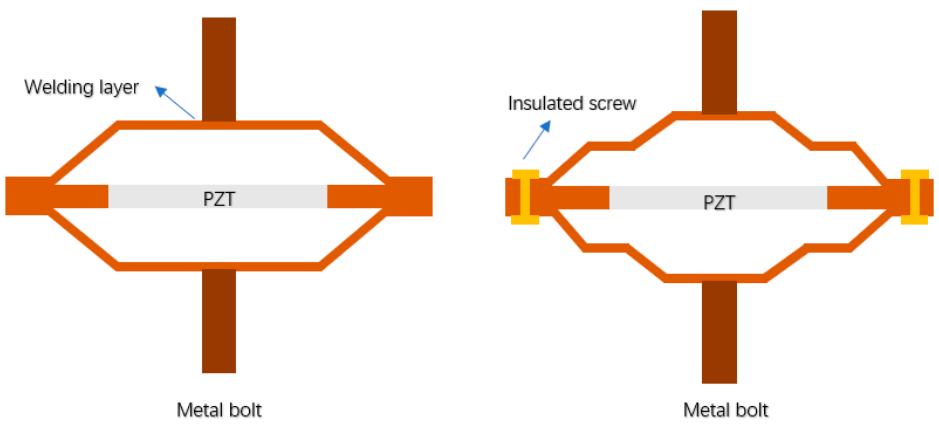
Figure 23. Asymmetric structure diagrams of cymbal. ( a ) Asymmetric configuration of end cap ( b ) Asymmetric configuration of end cap ( c ) Asymmetric material of end cap ( d ) Asymmetric cavity.